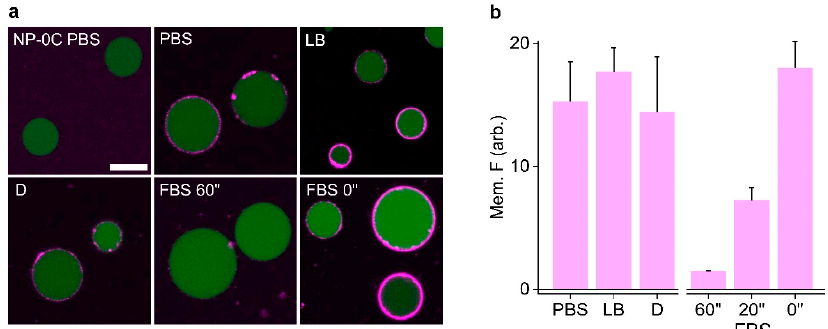
Figure 5. Confocal microscopy shows NP-3C binding to GUVs in biological buffers while FBS Figure 4. Identifying aggregation of DNA nanopores over time. Relative fluorescence intensities of complexes to NP-3C to block membrane tethering. ( a ) Cy3-labeled NP-3C ( magenta ) mixed in the Cy3-labeled ( a ) NP-0C and ( b ) NP-3C remaining in solution after centrifugation at 1, 24, and 48 h, in stated buffers for 1 h, and NP-3C added to FBS for different time periods, then added to GUVs the stated buffers; ( c ) CLSM images of Cy3-labeled NP-3C in the stated buffers at 1 and 24 h. Scale bar 50 µm.